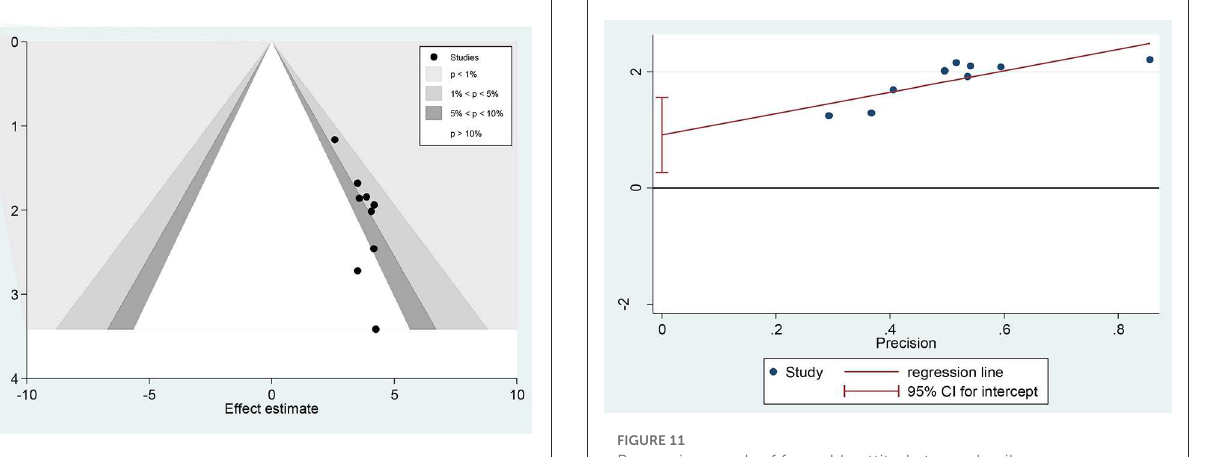
FIGURE9 Counter-enhanced funnel plots of publication bias for favorable attitude toward epilepsy.